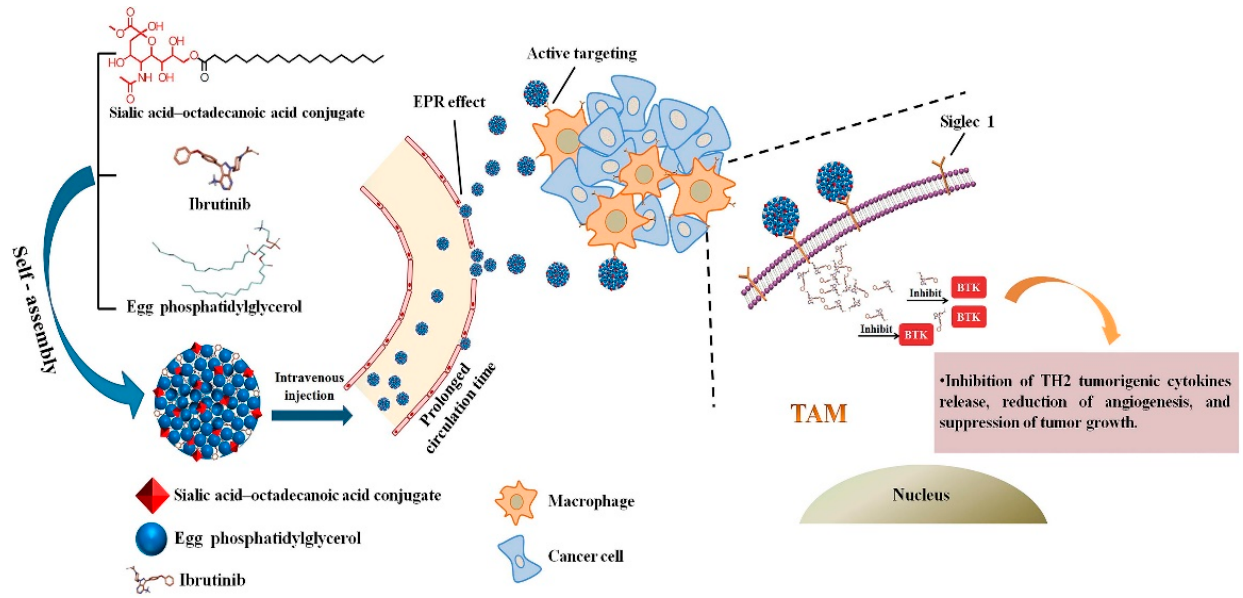
Figure 4. Graphic illustration of SA/IBR/EPG nano-system, tumor accumulation due to the EPR effect, and inhibition of Bruton’s tyrosine kinase function in TAMs leading to immunotherapeutic effects. Reprinted from [165].